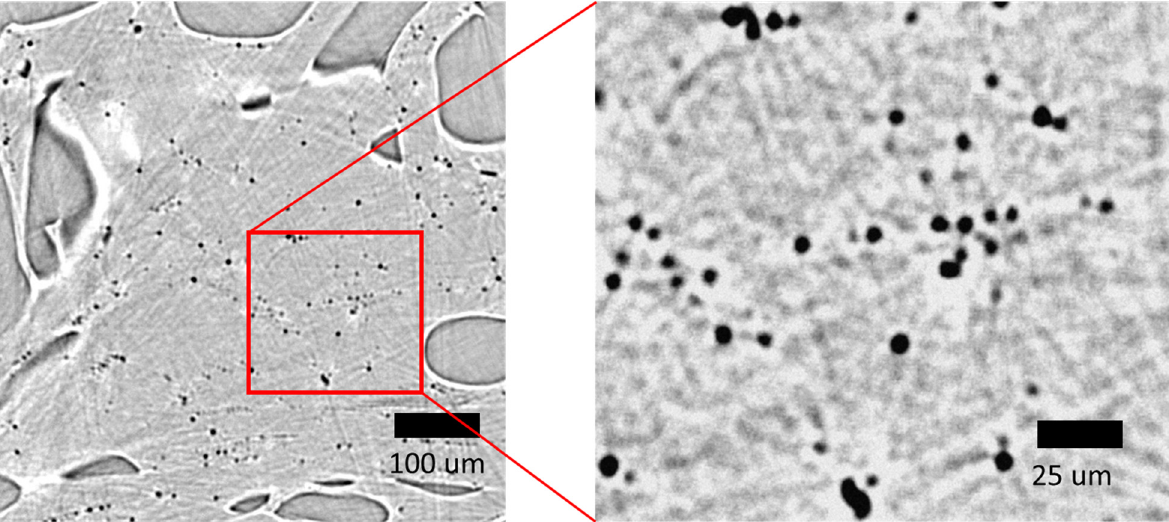
Figure 9. Synchrotron images of the cross-section of PLGA scaffold internal domains. The magnified image demonstrates the spherical form of the micro-pores. Image seems blurred due to the spatial resolution of micro-CT being approximately 3 μ m, while the effective pixel size is 0.8 μ m.